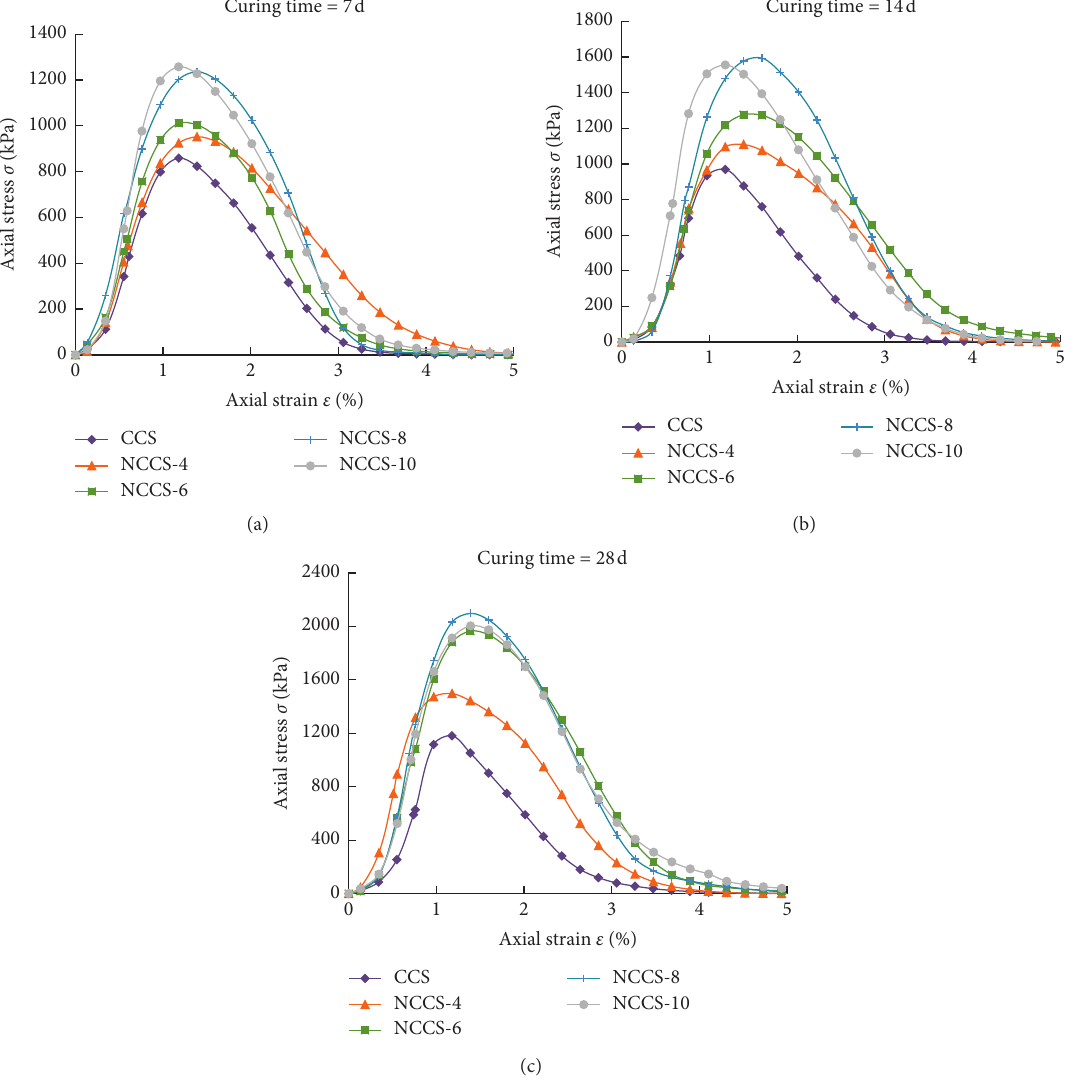
Figure 9: The stress-strain curves of NCCS with different admixture of nanoclay. (a) 7 d NCCS. (b) 14d NCCS. (c) 28d NCCS.